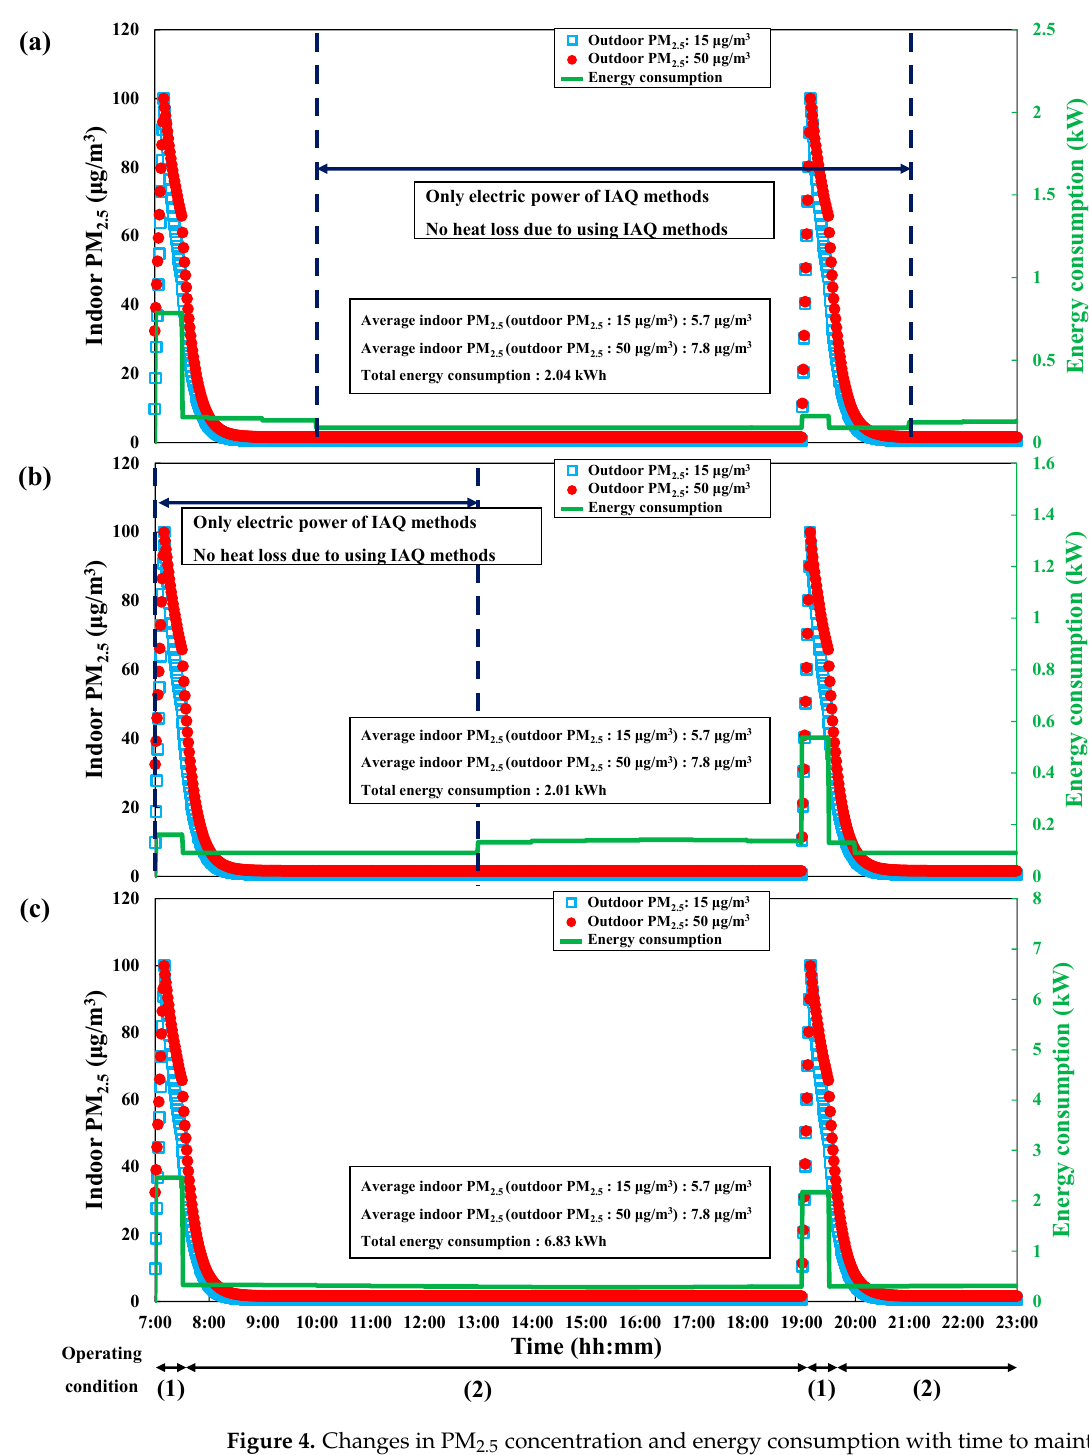
Figure 4. Changes in PM 2.5 concentration and energy consumption with time to maintain average Winter. Table 3. Operating conditions of IAQ management methods (NV: natural ventilation, MV: mechanical ventilation, RH: range hood, and AP: air purifier).